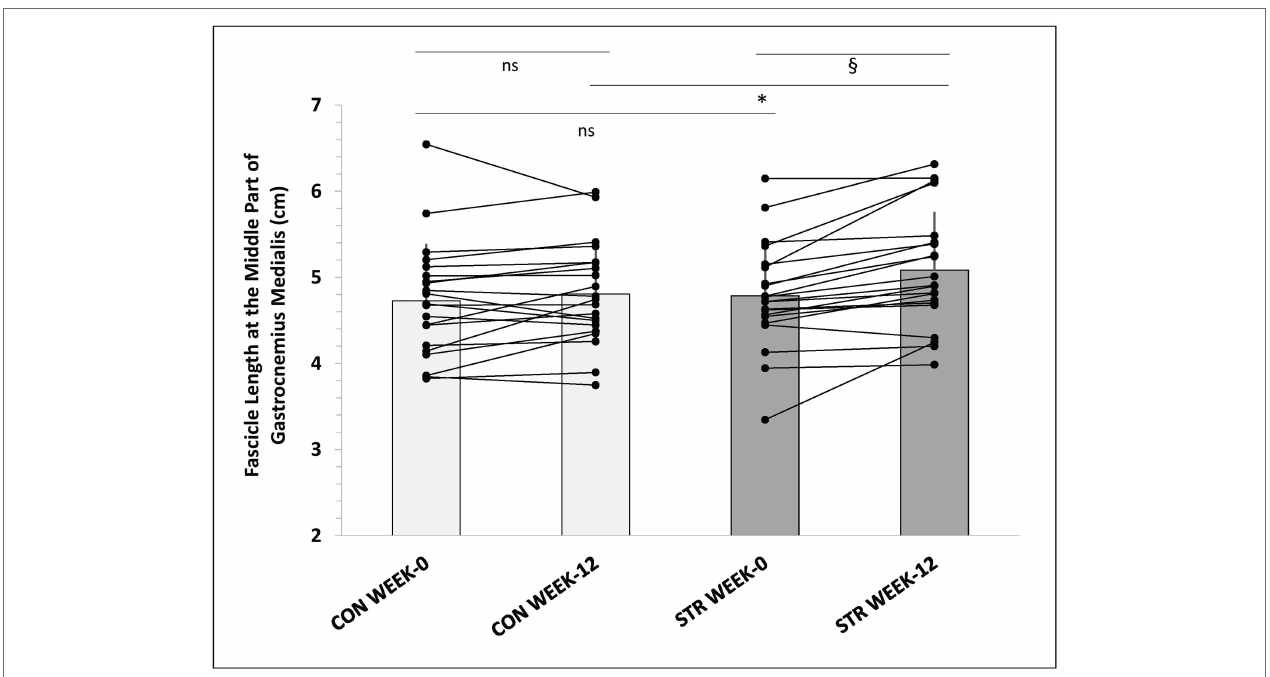
FIGURE 6 | Individualized values of fascicle length in the medial part of gastrocnemius medialis, at week-0 and week-12. *: p < 0.01 from the corresponding control leg value; §: p < 0.05 from the corresponding pre-intervention value to post-intervention value; CON, control leg; STR, stretched